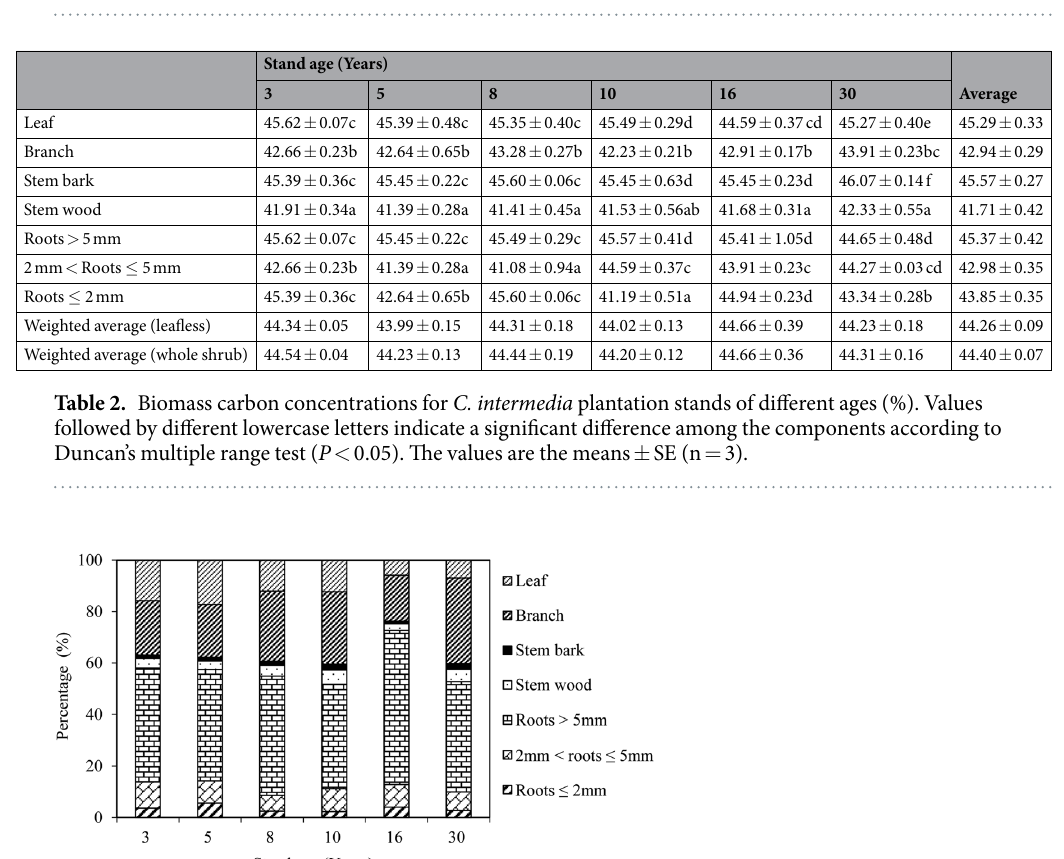
Table 1. Biomass of C. intermedia plantation stands of different ages (t·ha − 1 ). Values followed by different lowercase letters indicate significant differences among stand ages according to Duncan’s multiple range test ( P < 0.05). The values are the means ± SE (n = 3).